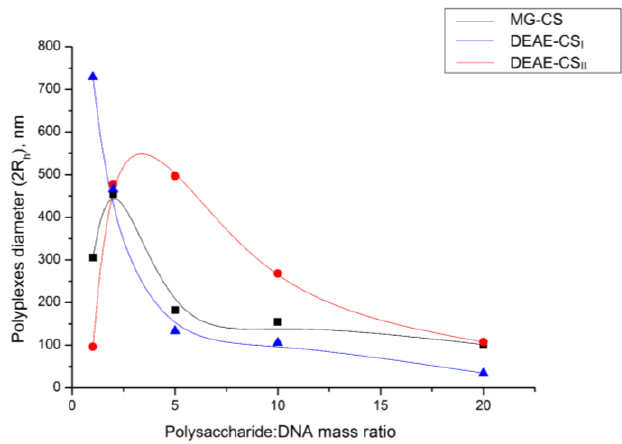
Figure 6. Hydrodynamic diameters of polyplexes formed by chitosan derivatives and DNA at different mass ratios.